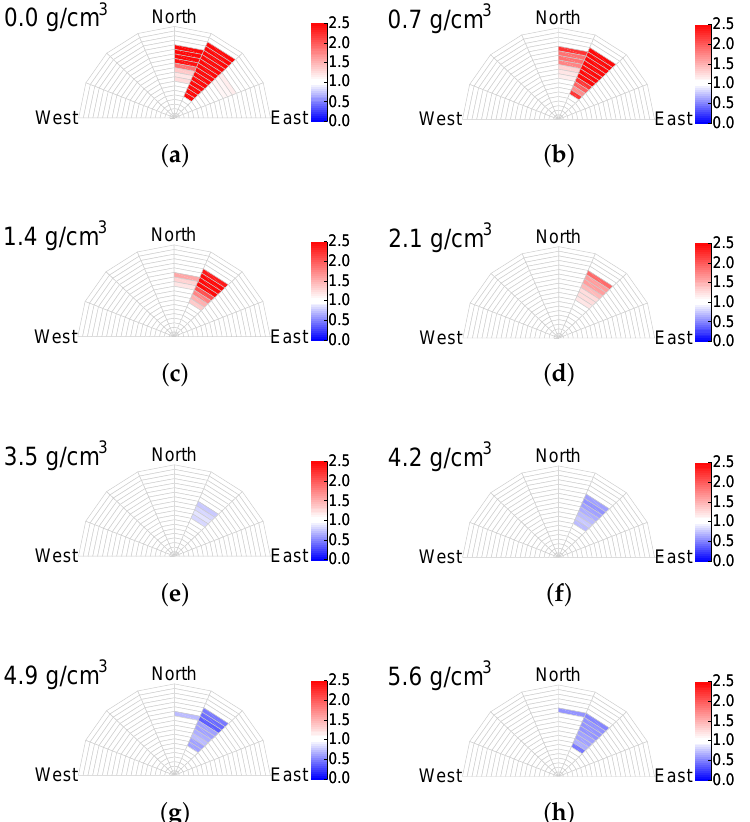
Figure 9. The ratio radar images of the density variation region, assuming a six-month data acquisition period with the detector placed outside the mountain. The radial dimension is the cos θ zen ; the innermost point and the outermost circle correspond to the vertical (cos θ zen = 1) and horizontal (cos θ zen = 0) direction of muon momentum, respectively. The southern part of each image is not drawn because it is within the detection range of the anti-coincidence detector. The densities of ( a – h ) are 0, 0.7, 1.4, 2.1, 3.5, 4.2, 4.9, and 5.6 g/cm 3 , respectively. The color shows the ratio r of the number of muons passing through the mountain within the density variation regions to the number of muons passing through the reference mountain. The division is weighted according to the data acquisition time. We set the r of the bins with the statistical significance < 3 σ to 1, which means there is no difference from the reference one, when plotting. The ratio uncertainty r unc of the colored bins satisfies r unc ≤ | r − 1 |